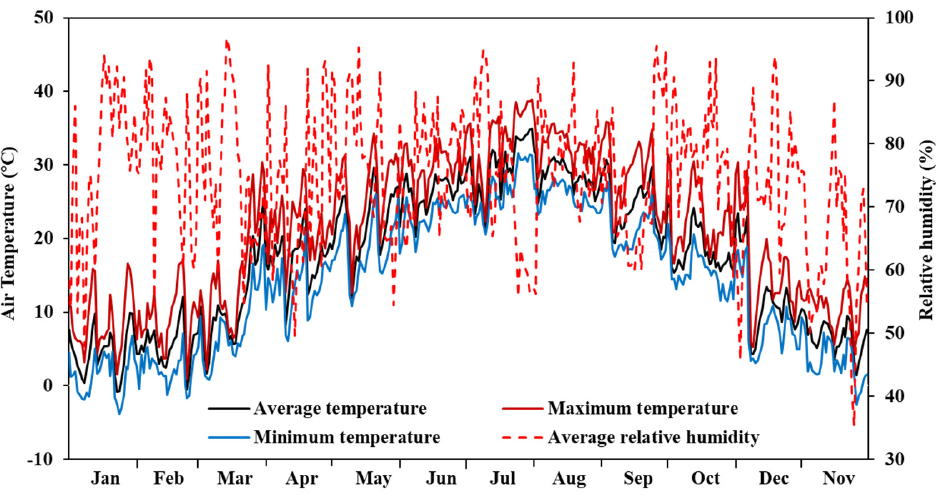
Figure 2. Daily temperature and relative humidity in Wuhan.